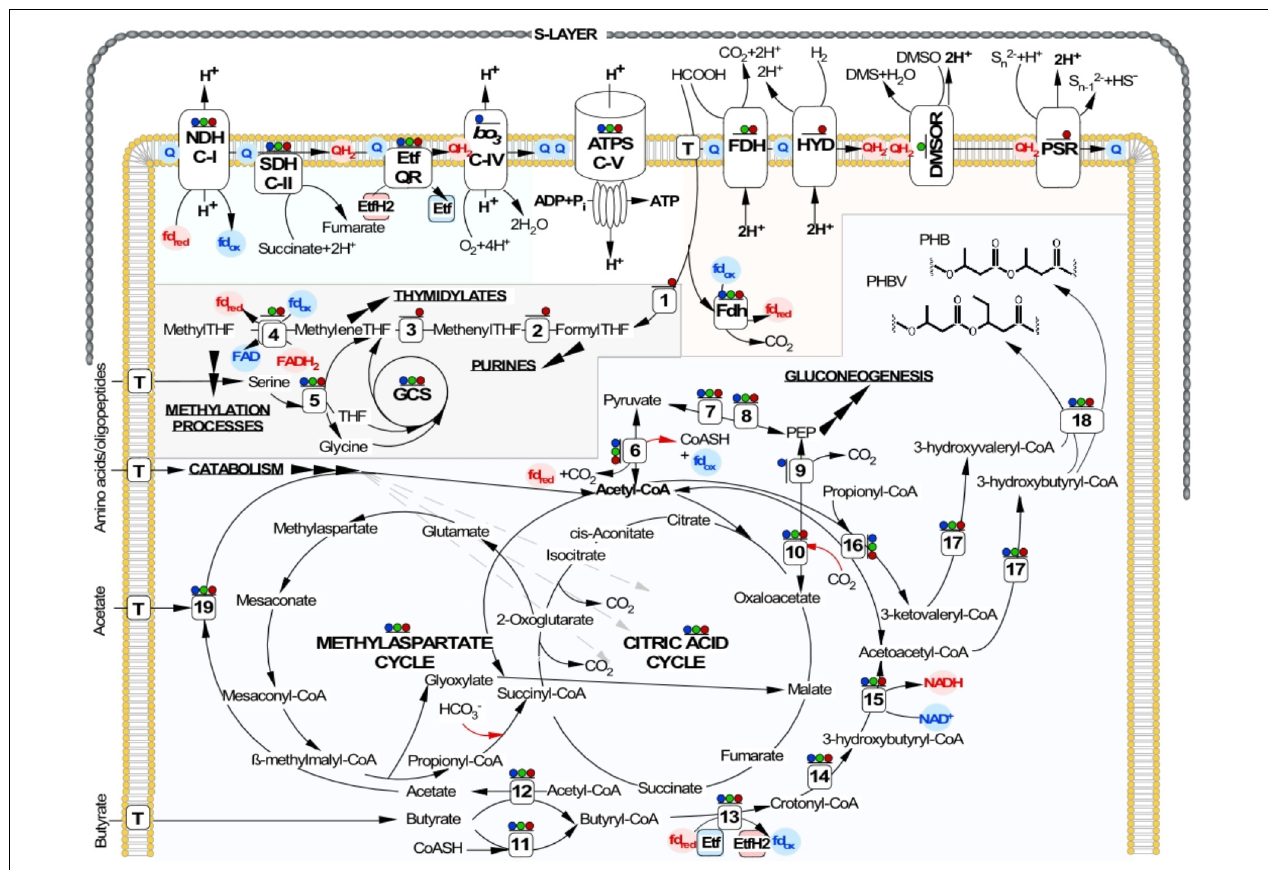
FIGURE 4 | Reconstruction of central metabolic pathways, energy generation and proton-translocation machinery shared by NLS strains. ATP synthesis by chemiosmotic coupling of proton transport via aerobic and anaerobic respiratory chains is shown at the top. Below, the C 1 metabolism, TCA and MAC cycles, as well as the SCFA oxidation and the PHA synthesis pathways are indicated. Inorganic carbon fixation is shown by red arrows. Presence of all enzymes in corresponding proteomes is shown as colored dots above: aerobic growth on butyrate – blue dots; anaerobic growth on formate (electron donor) and yeast extract (carbon source) with DMSO (electron acceptor) – green dots; with elemental sulfur (electron acceptor) – red dots. Enzymes involved: ATPS, archaeal ATP synthase; NDH C-I, Complex I NADH/ferredoxin dehydrogenase (ubiquinone); SDH C-II, Complex II succinate dehydrogenase; bo 3 C-IV, Complex IV cytochrome bo 3 ubiquinol oxidase, FDH, formate dehydrogenase; HYD, uptake hydrogenase; DMSOR, DMSO reductase; PSR, polysulfide reductase; Etf, electron transfer flavoprotein; Etf QR, electron transfer flavoprotein quinone reductase; GCS, glycine cleavage system; T, corresponding transporters; (1) formate—tetrahydrofolate ligase; (2) 5,10-methylenetetrahydrofolate reductase; (3) methylenetetrahydrofolate dehydrogenase; (4) methylenetetrahydrofolate reductase; (5) serine hydroxymethyltransferase; (6) pyruvate:ferredoxin oxidoreductase; (7) pyruvate kinase; (8) PEP synthase; (9) PEP carboxykinase; (10) PEP carboxylase; (11) acyl-CoA synthase; (12) acyl-CoA:acetate/3-ketoacid CoA transferase; (13) acyl-CoA dehydrogenase; (14) Enoyl-CoA hydratase; (15) 3-hydroxyacyl-CoA dehydrogenase; (16) acetyl-CoA acetyltransferase; (17) 3-ketoacyl-ACP reductase; (18) PHA synthase; (19) acetyl-CoA